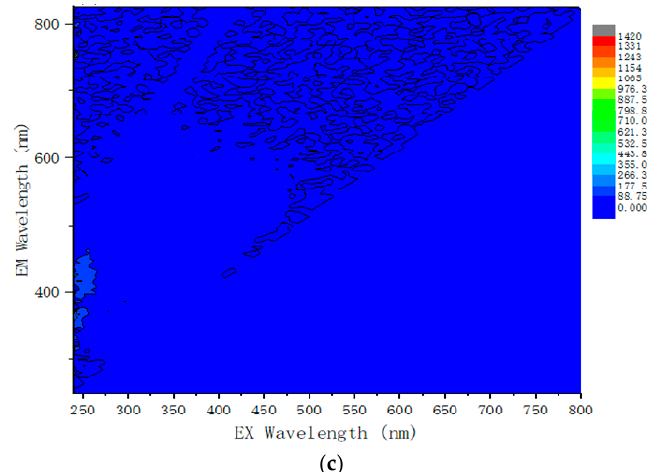
Figure 10. Three-dimensional fluorescence spectrum of SDZ water sample under river water quality conditions (reaction conditions: excitation light source, deuterium lamp; photomultiplier tube (PMT) voltage, 500 V; response time, 0.5 s; scanning speed, 2400 nm/min; excitation wavelength scanning range was 200–400 nm, step size was 2 nm; emission wavelength scanning range was 250–500 nm, step size 2 nm; slit width, 5 nm). ( a ) Raw water, ( b ) Treatment for 20 min, ( c ) Treatment for 60 min.